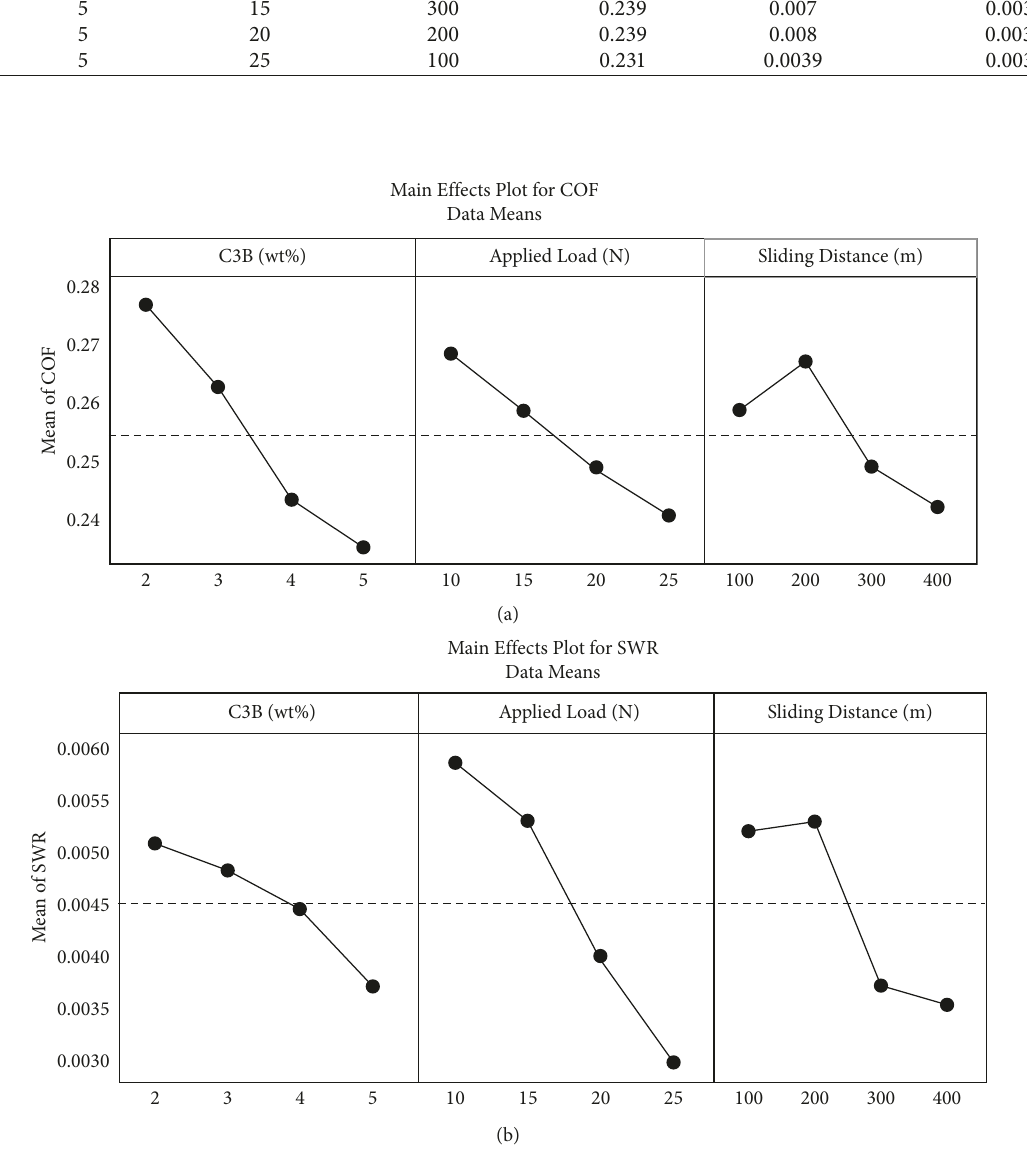
Figure 4: (a) Main effect plots of coefficient of friction. (b) Main effect plots of specific wear